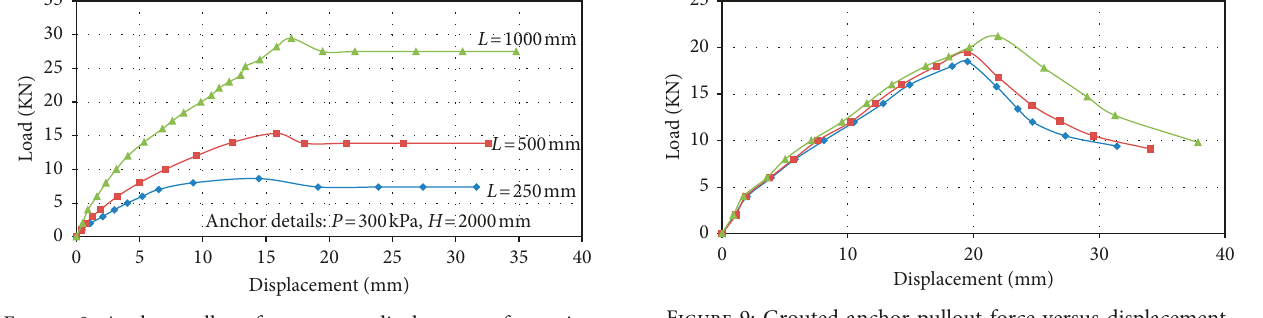
Figure 8: Anchor pullout force versus displacement for various rubber pneumatic bag lengths.